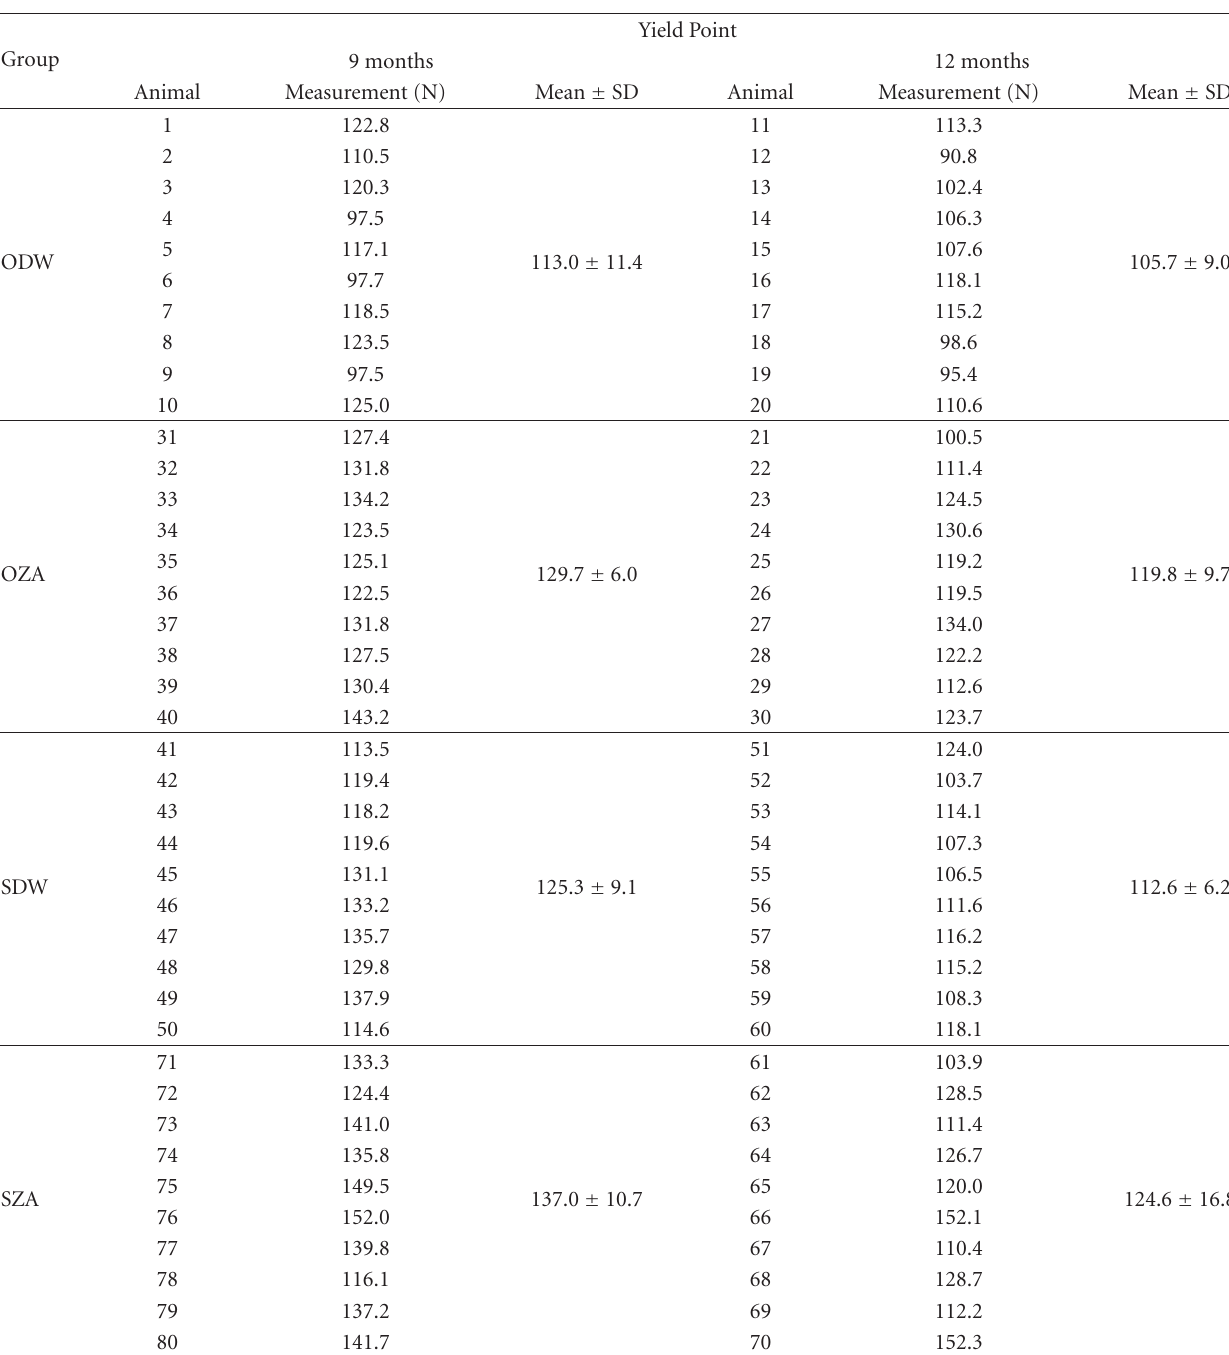
Table 2: Yield point (N) at 9 and 12